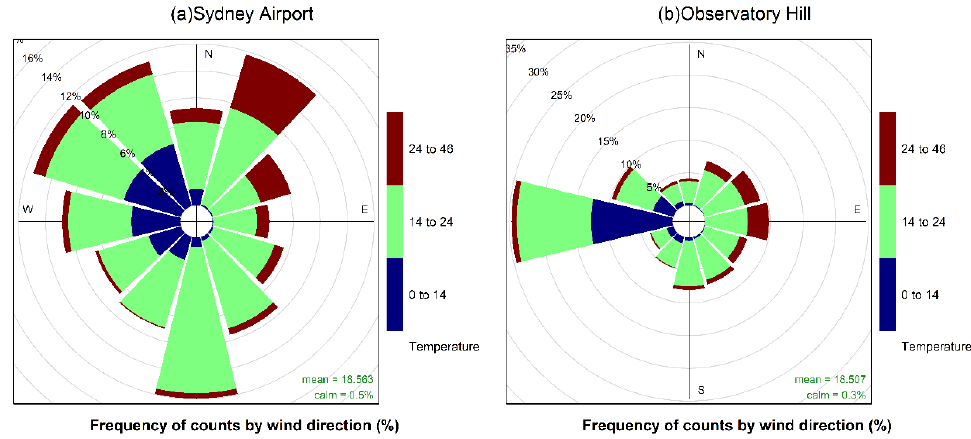
Figure 4. Distribution of wind directions for different air temperatures at the ( a ) Sydney airport and ( b ) Observatory Hill stations.